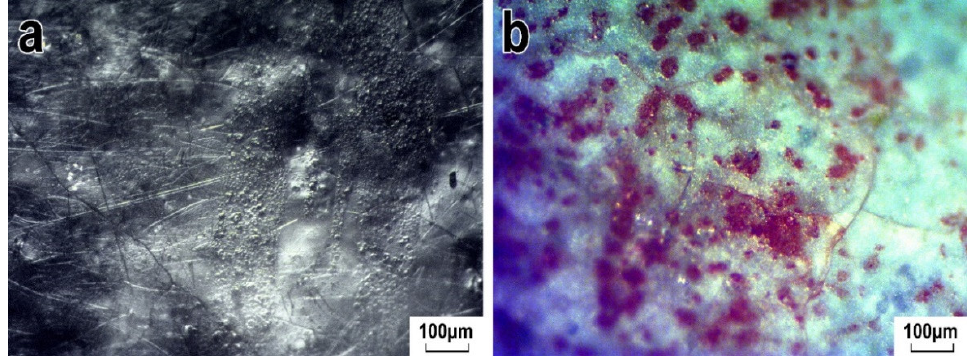
Figure 9. OM images of surface texture of the black area ( a ) and red area ( b ) on the separate fragment of the figurine. The magnification is 50×.